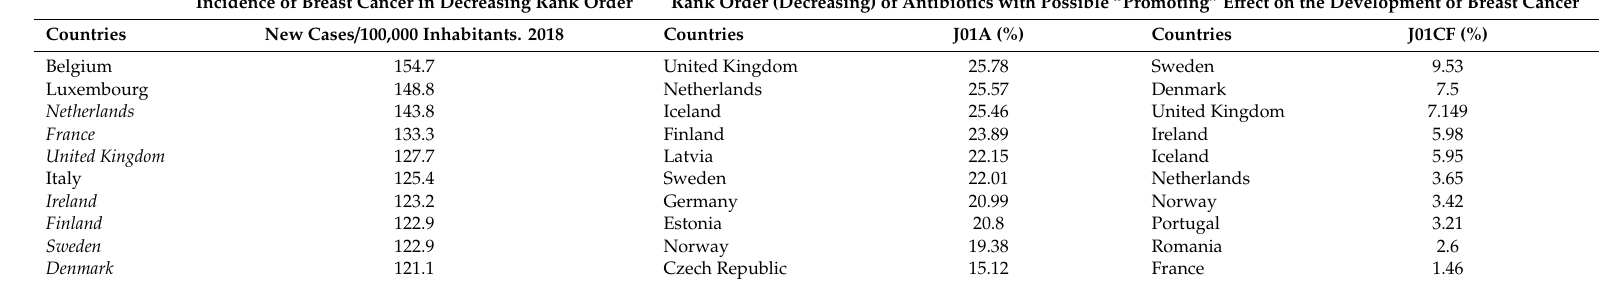
Table 5. Rank order (decreasing) of the incidence of breast cancer (10 countries) compared to the rank order (decreasing) of antibiotics with suspected “promoter” e ff ect. Of the first ten countries with the highest incidence rate of breast cancer, seven countries can be found among the highest consumption figures of “promoter” antibiotics (bold. italics). Rank Order (Decreasing) of Antibiotics with Possible “Promoting” E ff ect on the Development of Breast Cancer Countries